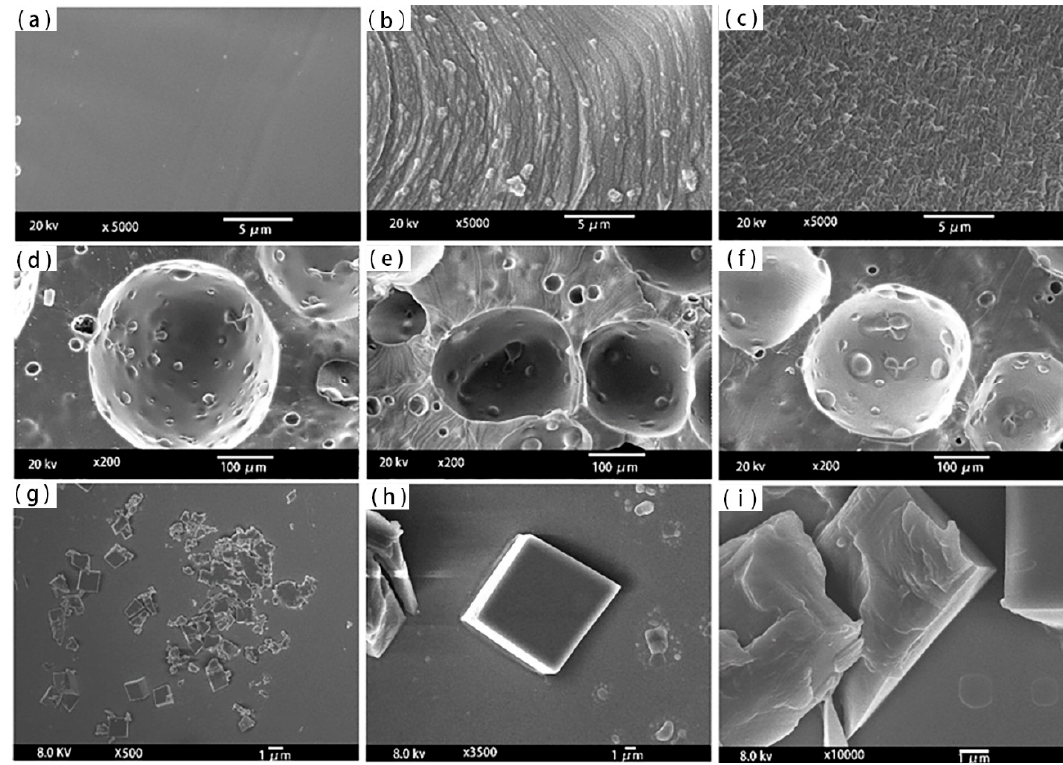
Figure 9. The cell morphology of MAPOSS and polysiloxane foams: ( a , d ) S1, ( b , e ) S4, ( c , f ) S6, and ( g – i ) MAPOSS.